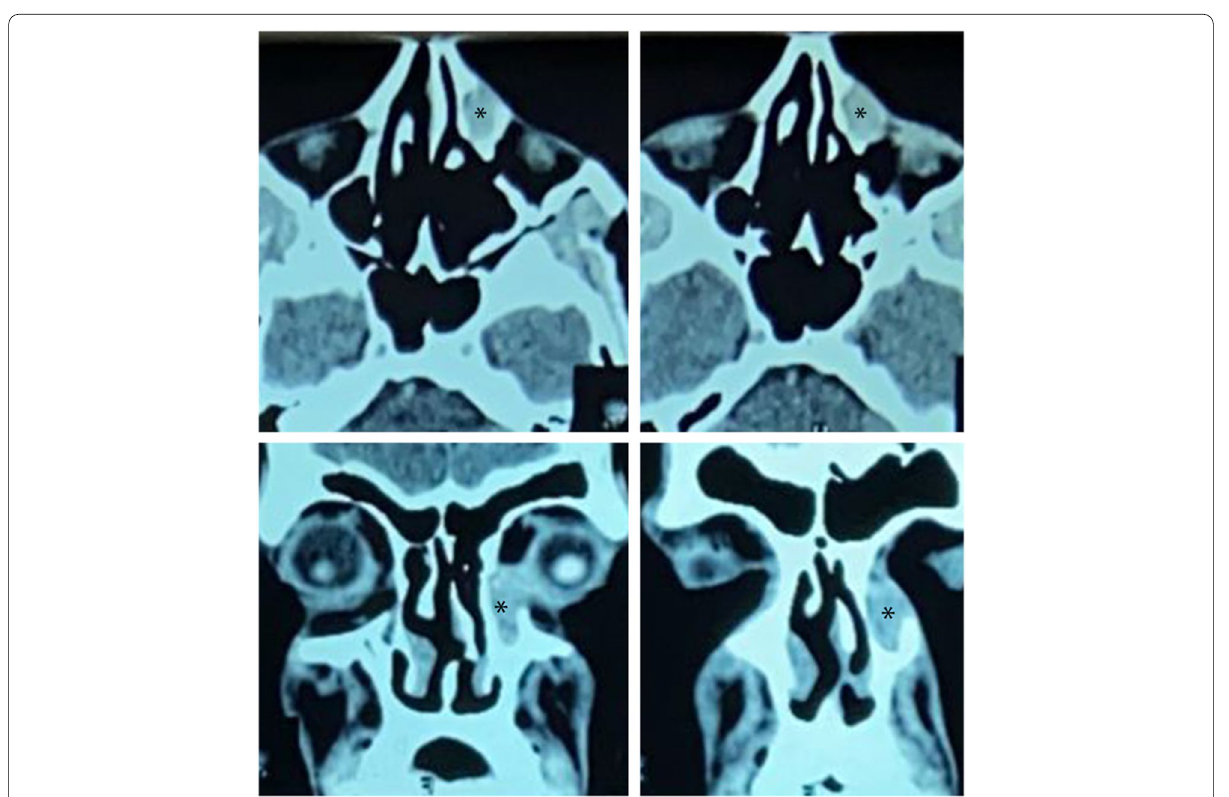
Fig. 2 CT scan showing a homogeneous lesion in the lacrimal region on the left side